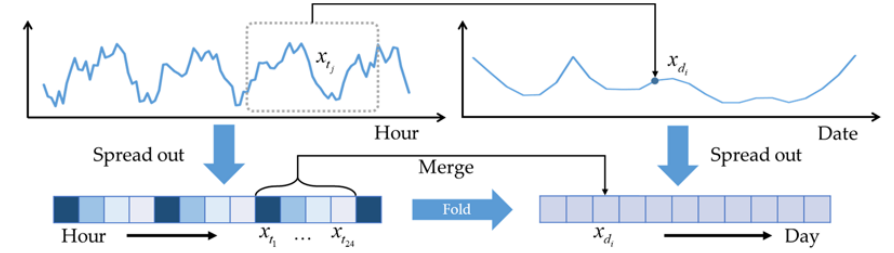
Figure 1. One ‐ dimensional data structure of electricity consumption data. Figure 1. One-dimensional data structure of electricity consumption